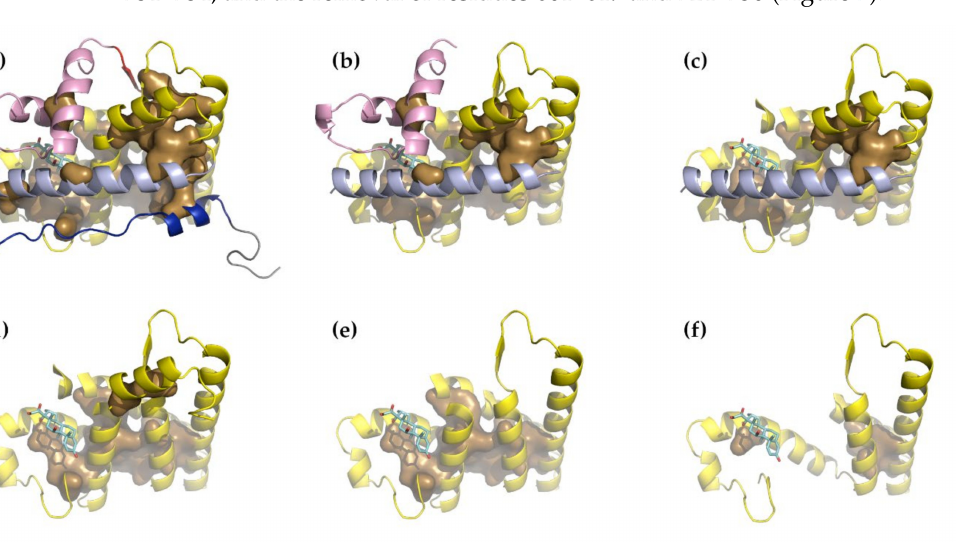
Figure 7. A series of truncations of the GCR-LBD suggested by considering the buried residue distribution and the results of NMA. ( a ) The whole GCR-LBD domain; ( b ) the first truncation, lacking NT1 and CT1; ( c ) the second truncation, lacking CT2; ( d ) the third truncation, lacking NT2; ( e ) a forth truncation, lacking residues 583–600 and 731–734; and ( f ) a fifth truncation, lacking residues 601–619 and 724–730. The structures are colored in the following way: blue: NT1, residues 530–554; light blue: NT2, 555–582; pink: CT2, 735–767; red: CT1, residues 768–777. The first 8 N-terminal residues (523–529, gray) were exceptionally mobile and dominated the first 10 non-zero normal modes and were removed from the analysis. The buried core residues are shown in sandy brown and the remaining core is